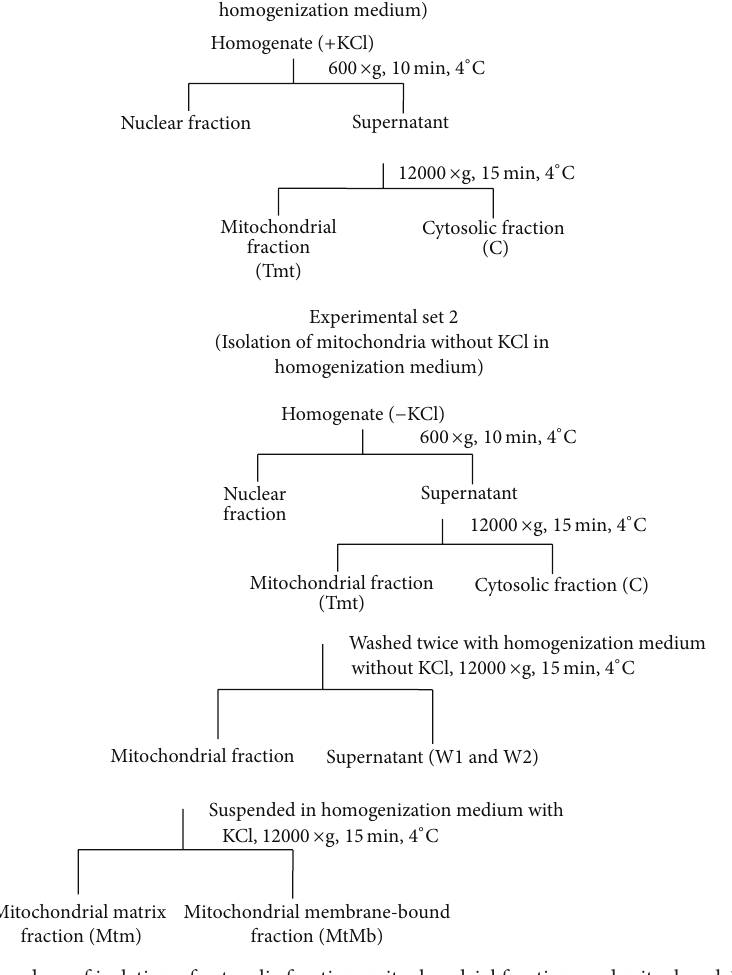
Figure 1: Flow chart of the procedure of isolation of cytosolic fraction, mitochondrial fraction, and mitochondrial outer membrane-bound fraction. The experimental set 1 mitochondria were isolated with KCl in homogenizing medium and experiment set 2 in which mitochondria were isolated first and then washed with different concentration of KCl in homogenizing